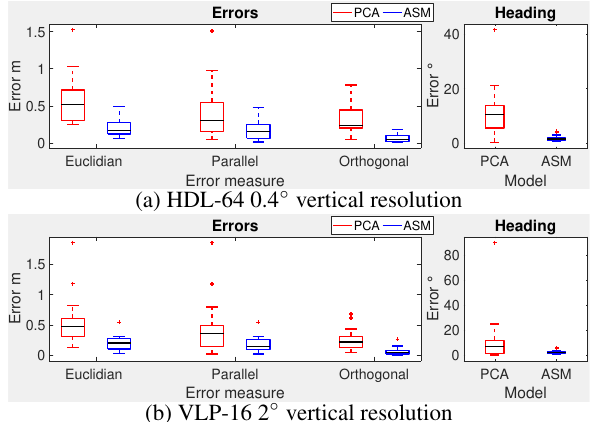
Figure 5. The mean error of the models for the sedan type car. Split in the total Euclidean error, the error along the car axis (left) and the heading error (right) racy by 0.34 m (0.54 m to 0.2 m) in Velodyne HDL-64 scans